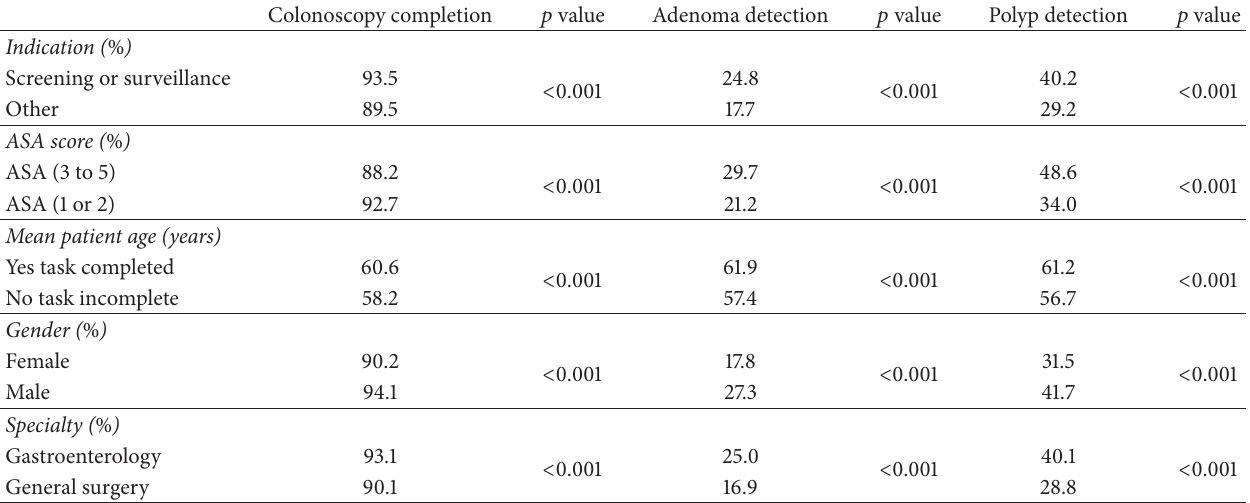
Table 3: Univariate analysis of potential confounding variables associated with colonoscopy completion, adenoma detection, and polyp detection.